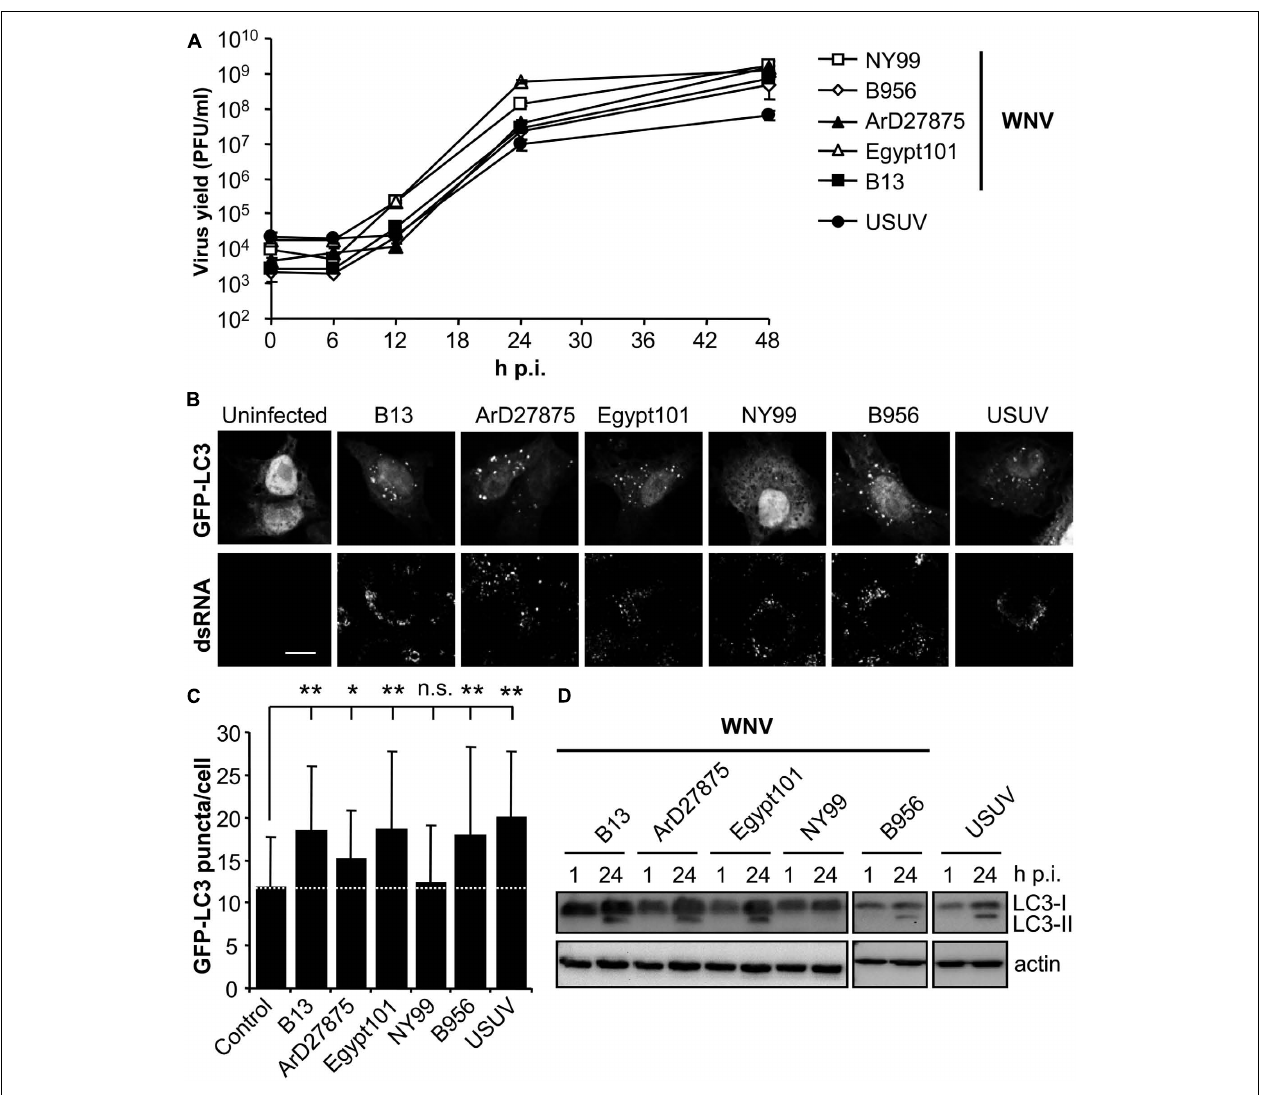
LC3 aggregates per cell. The number of fluorescent aggregates on the cytoplasm of cells infected in (B) was determined. Dashed line indicates the mean number of GFP puncta aggregates found in uninfected cells. Statistically significant differences between infected and uninfected cells are denoted by one asterisk (*) for P < 0.05 or two asterisks (**) for P < 0.005. n.s. denotes not statistically significant differences. (D) Monitoring LC3 modification following infection by WNV or USUV. Vero cells infected with different WNVs or USUV (MOI of 0.5 PFU/cell) were lysed at 1 or 24 h p.i. and subjected to western blot analysis using an antibody against LC3 to detect non-lipidated LC3 (LC3-I) and LC3 conjugated to phosphatidylethanolamine (LC3-II). An anti- β -actin antibody was also used as control for protein